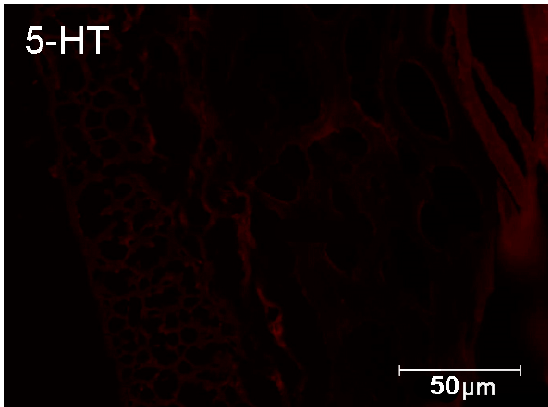
Figure 11. Negative control for 5-HT.